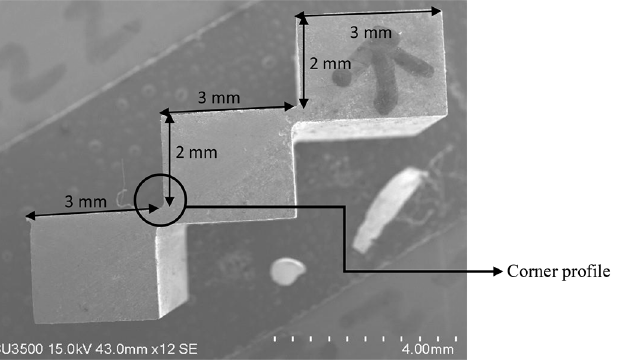
Table 5. Utility value of responses.